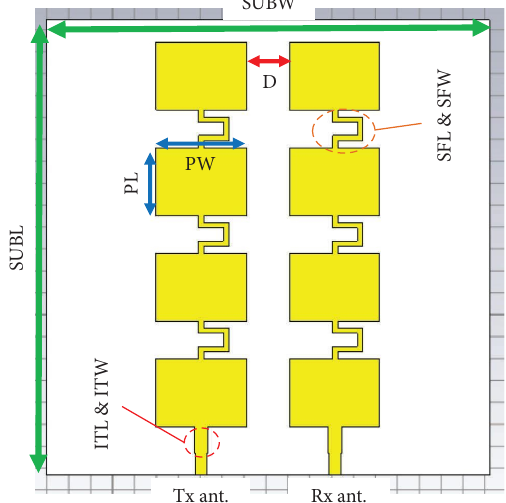
Figure 8: Tx leakage levels against the phases of the refection coefcients of the Tx and Rx antennas with Γ from equation (7).